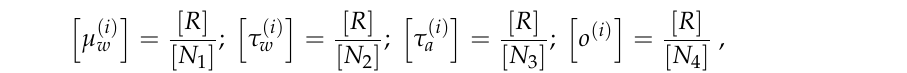
Table 1 below lists the units of the adjoint functions for four responses: R (cid:44) T R (cid:44) RH ( 1 ) and R (cid:44) m